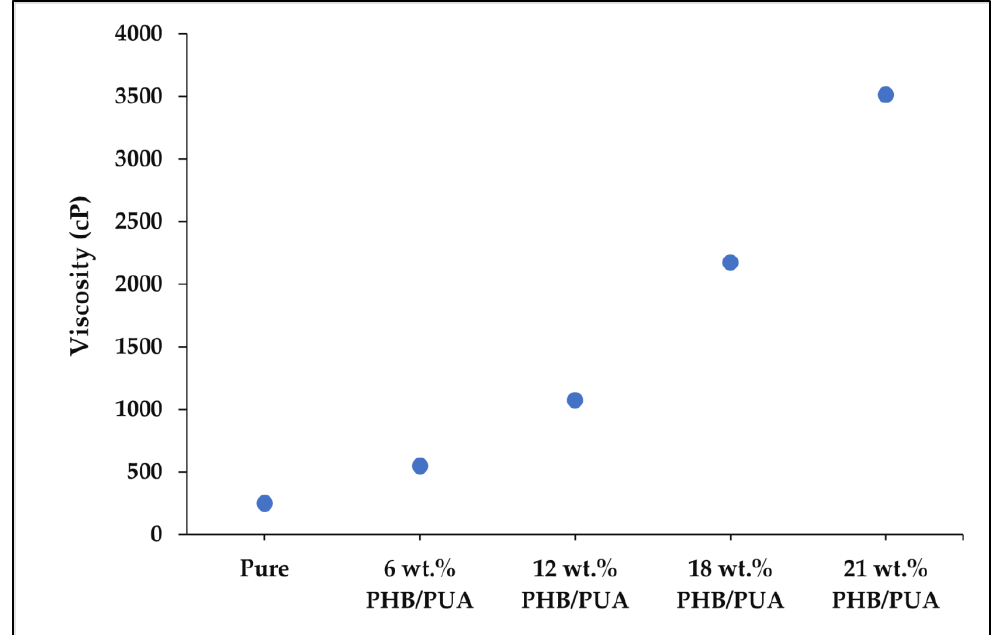
Figure 2. The viscosity value of PHB/PUA blends resin